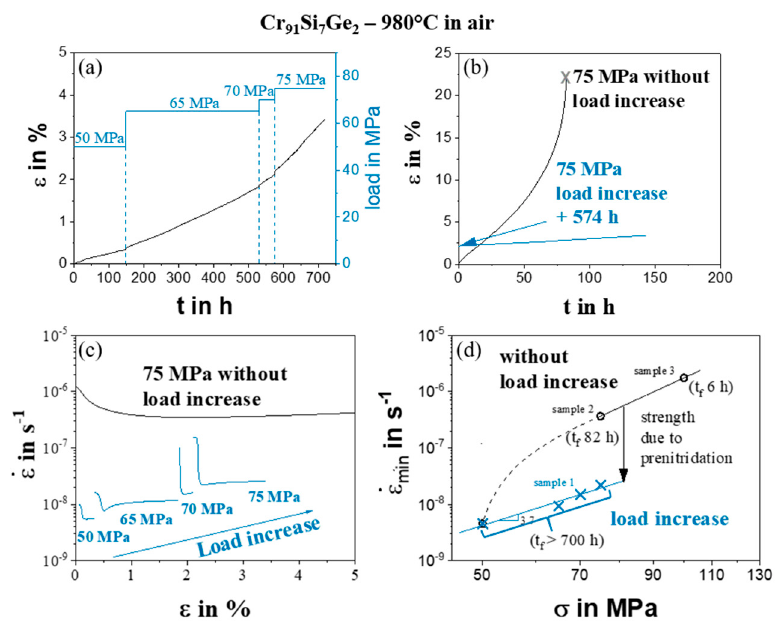
Figure 4. Load increase of alloy Cr 91 Si 7 Ge 2 at 980 °C in air. ( a ) Creep curve with increasing load from 50 to 75 MPa. ( b ) Comparison of 75 MPa strain curves ( c ) Comparison of strain rate vs. strain and ( d ) Norton-plot with minimum creep rate ε(cid:4662) min versus stress of specimen with (blue—sample shown in Figure 4a) and without (black) prior load increase and time to failure (t f ) in brackets. Sample 1, 2 and 3 refer to the samples shown in Figure 2c measured with constant loads of 50–75 MPa, 75 MPa and 100 MPa.